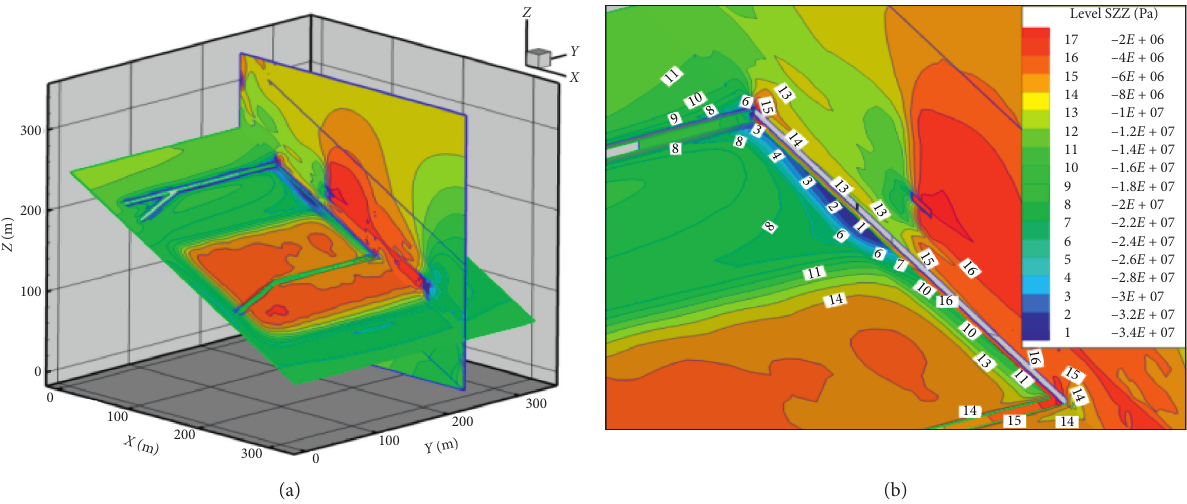
Figure 17: Vertical stress distribution in the 12124 working face. (a) 3D section of the mining area (along the working face dip). (b) An enlarged image of part of the working